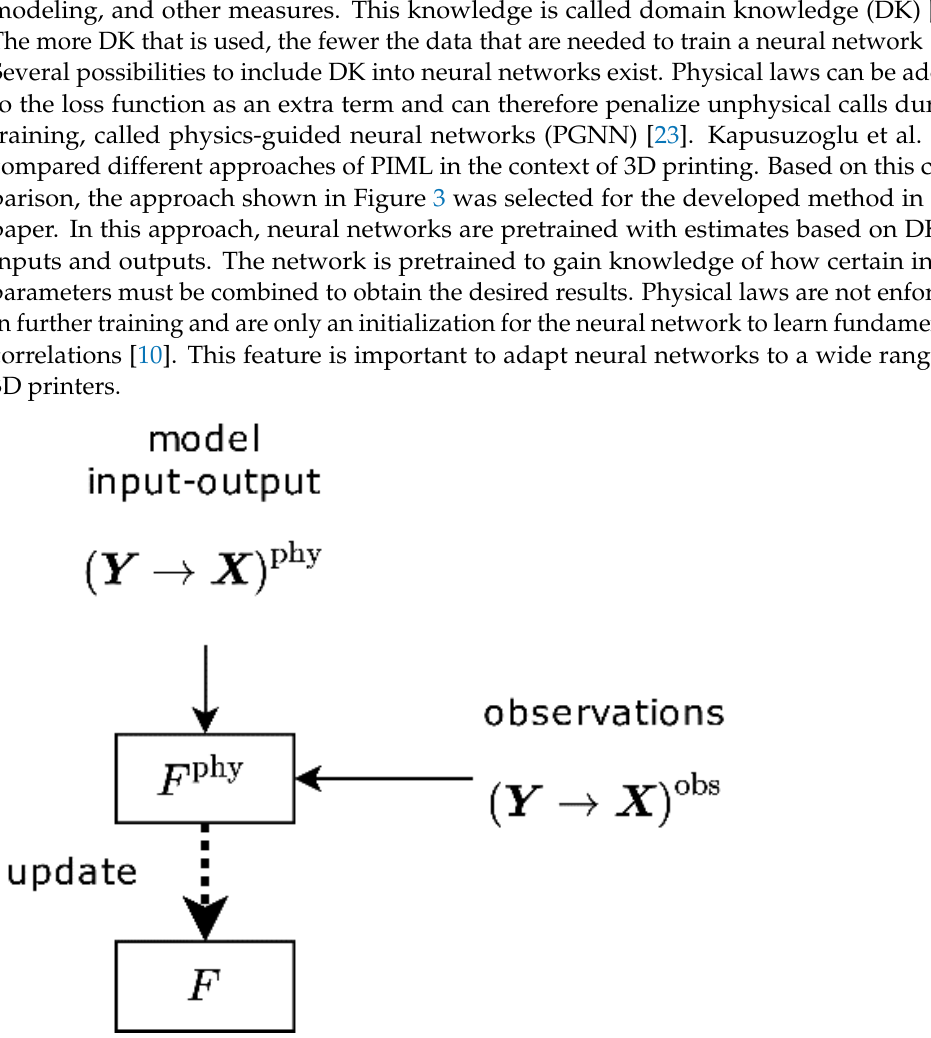
Figure 3. Physical knowledge can be included in machine learning by pretraining a neural network with input and output from a model, based on Figure 4c (Kapusuzoglu et al. [10]).